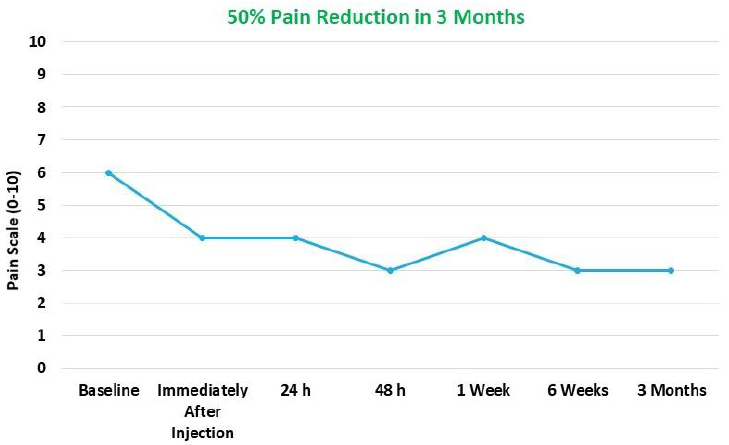
Figure 2. Numeric Pain Rating Scale (NPRS); 50% pain reduction over a period of 3 months compared to baseline.